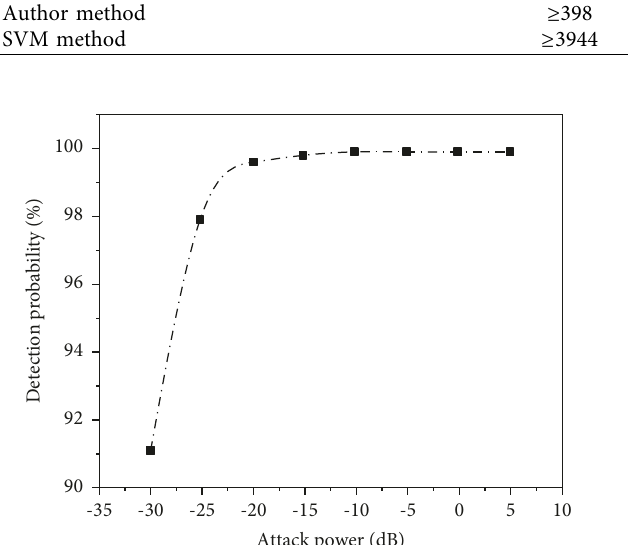
Figure 6: Variation curve of detection probability with attack